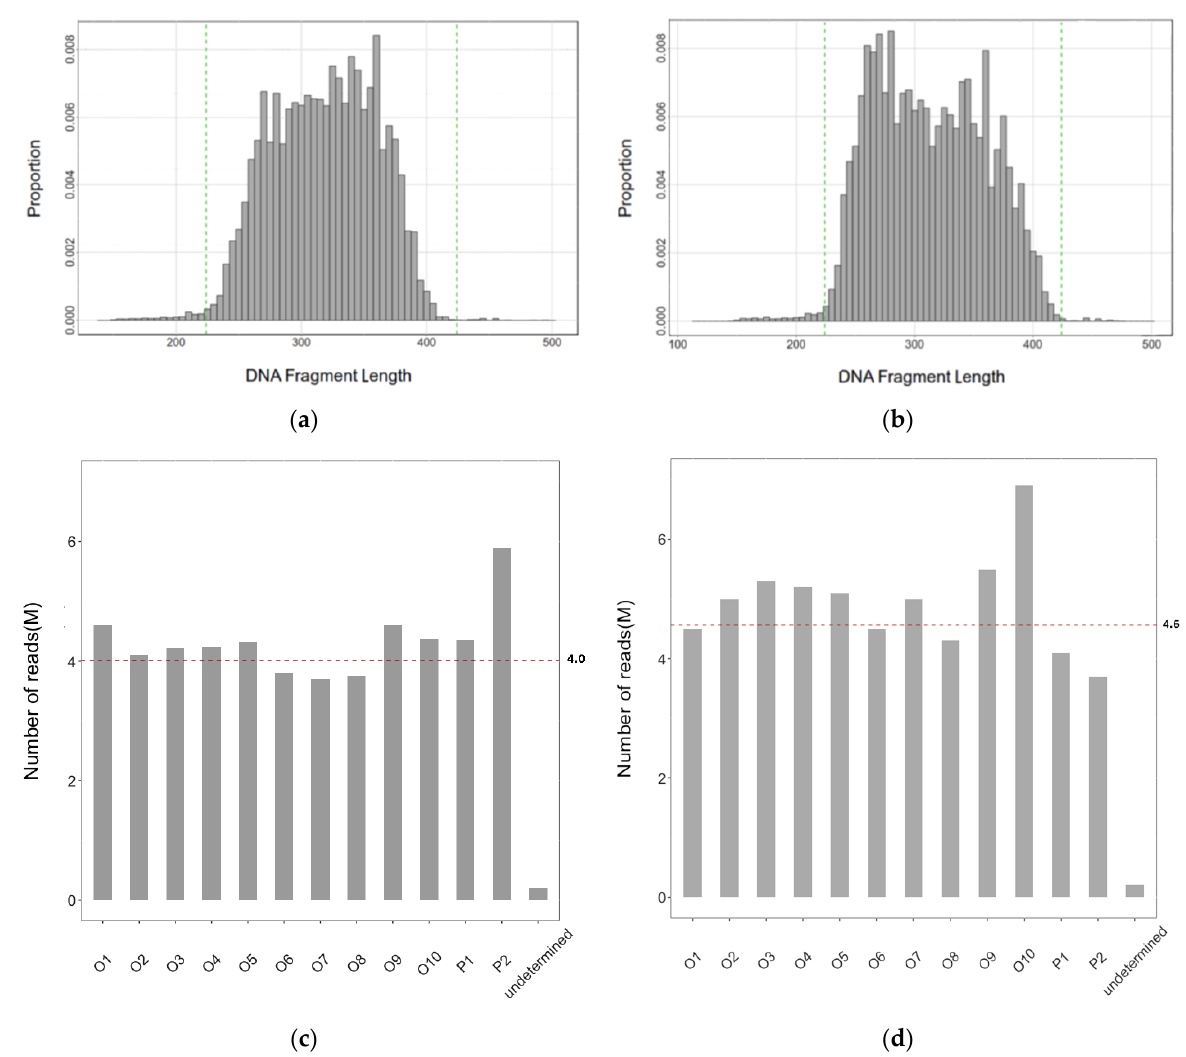
Figure 1. Distribution of the lengths of DNA segments ( a , b ) and the number of sequence reads in each of the pooled RAD-seq libraries comprising 12 diploid and tetraploid samples ( c , d ). The green lines in ( a , b ) bracket the ranges of the designed length of the DNA segments. The red dashed lines in ( c , d ) show the average number of reads per sample. ( a , c ) Diploids; ( b , d ) tetraploids.